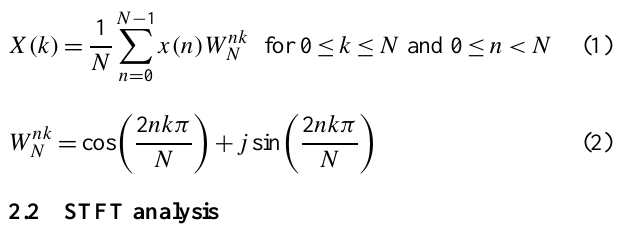
Figure 1. Structural simulator. 3